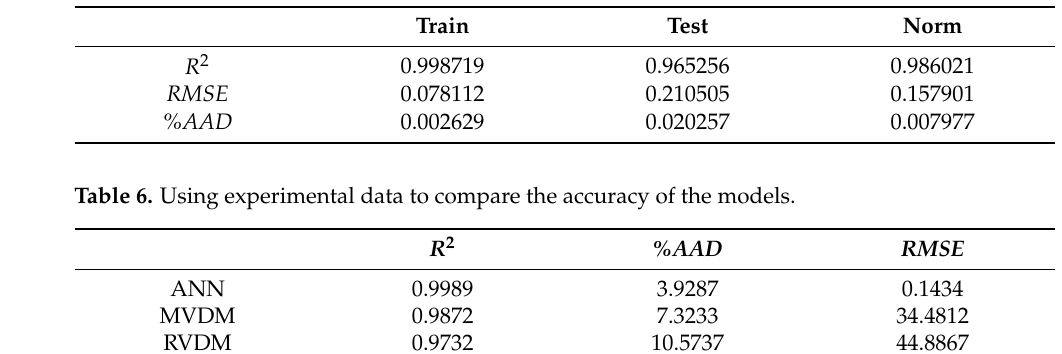
Table 5. Summary of the statistical results of the ANN model using literature data.